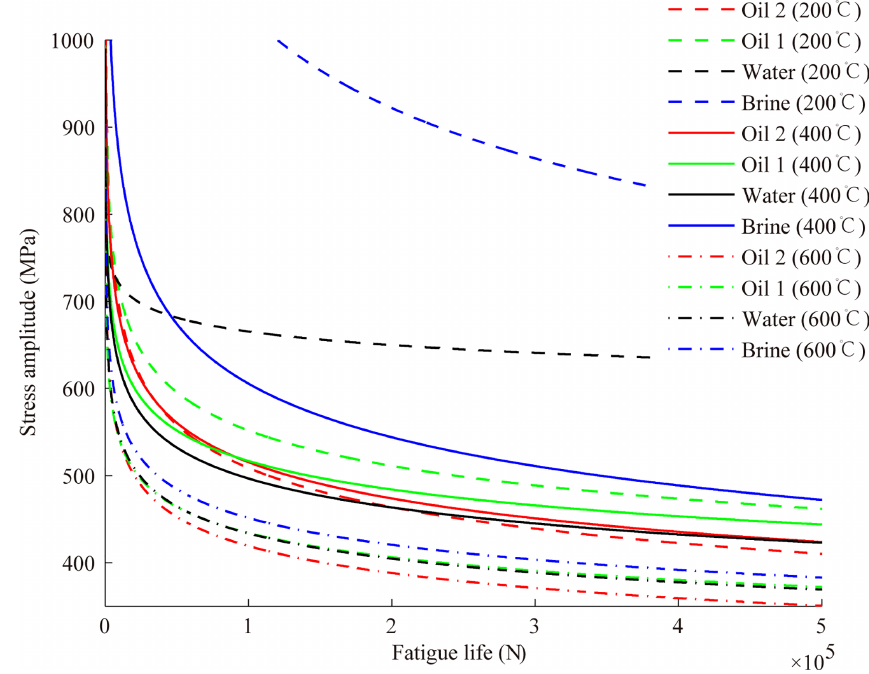
Figure 4. The S–N curves with the tempering temperature 500, 600 and 700 ◦